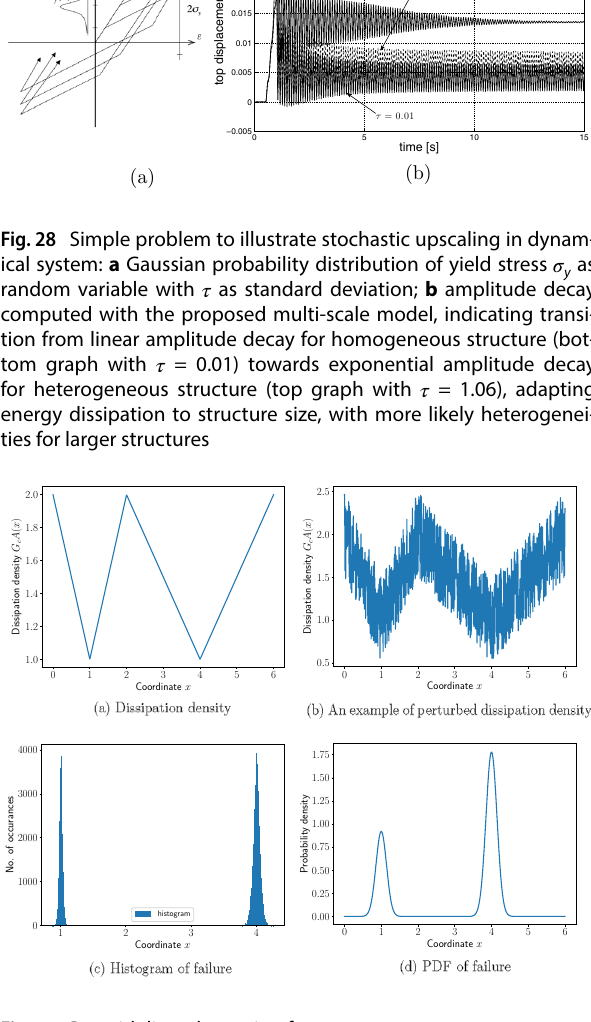
[59], with their relative contribution handled by a Hidden Semi-Markov Model [51]. Consequently, the model can capture the scale effect with changes in the